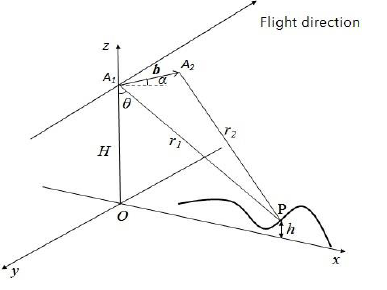
Figure 1. Dual-baseline airborne InSAR height measurement geometry